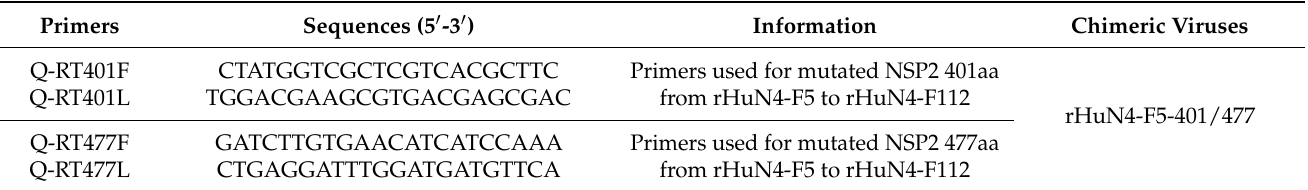
Table 1. Information of primers and chimeric